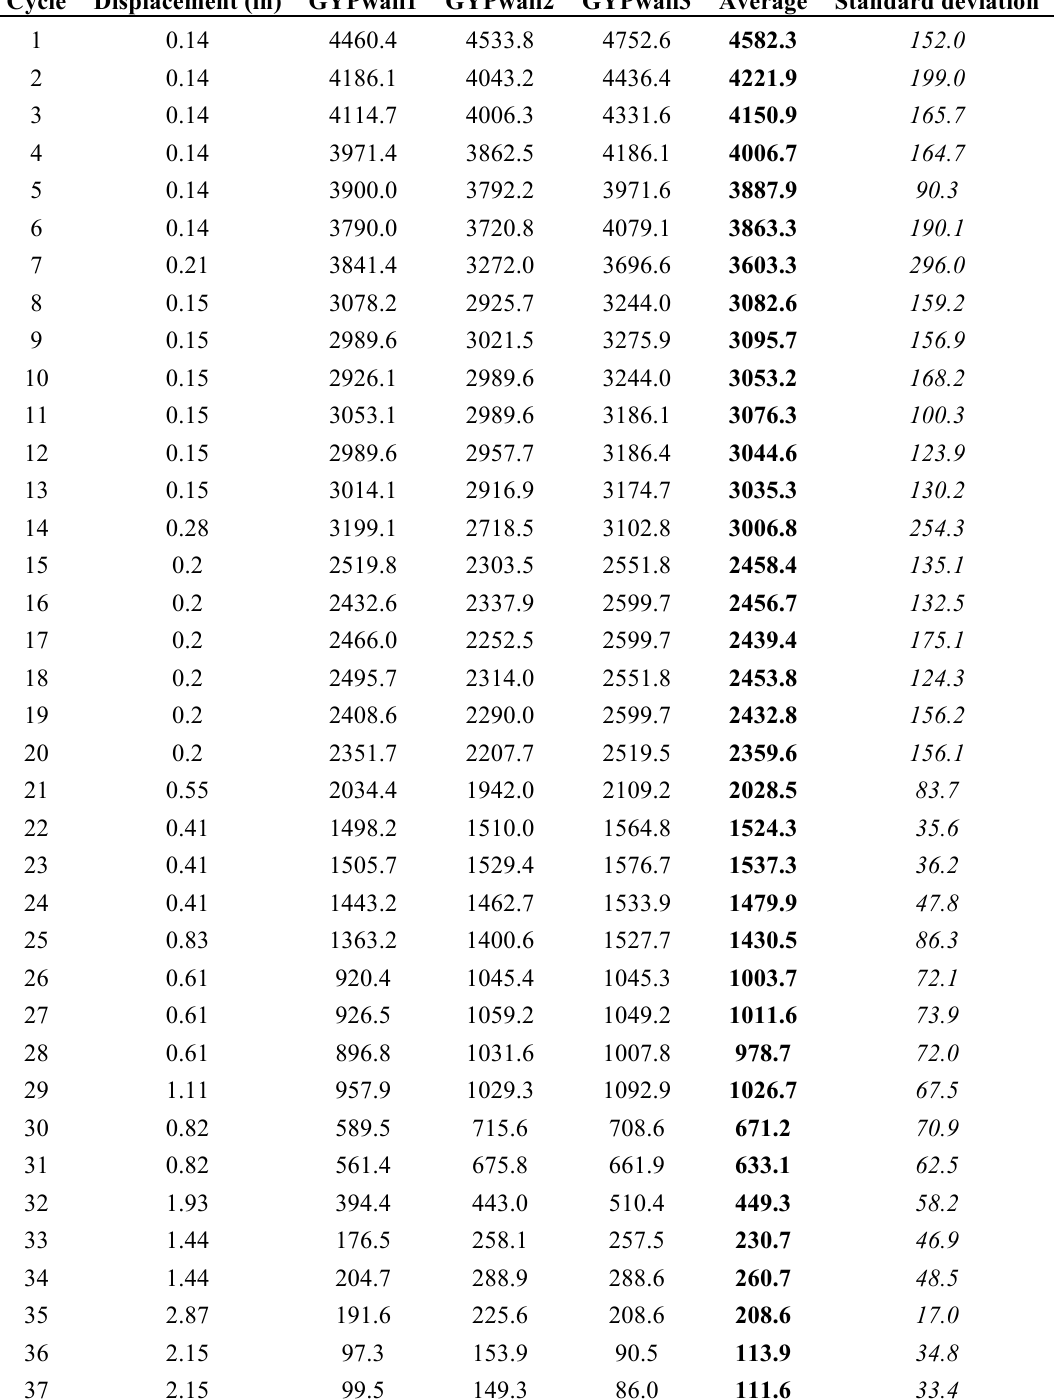
Table 5. Stiffness (lb/in) of